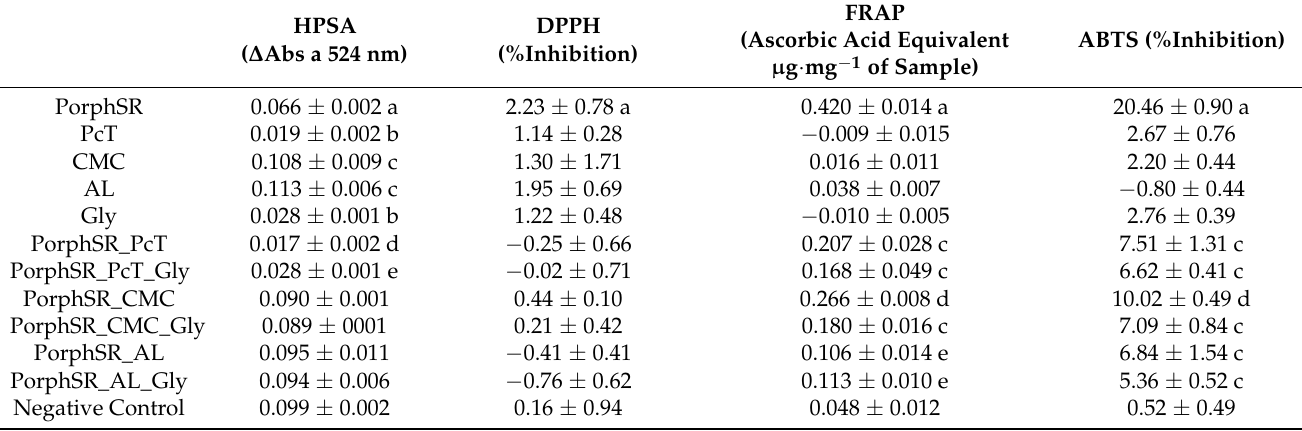
Table 3. Compilation of the antioxidant properties of PorphP2 extract, pectin (PcT), sodium car- boxymethylcellulose (CMC), sodium alginate (AL), glycerol 86–88% (Gly) films and developed films. Lowercase letters on data symbolize the statistically significant differences with a significance of